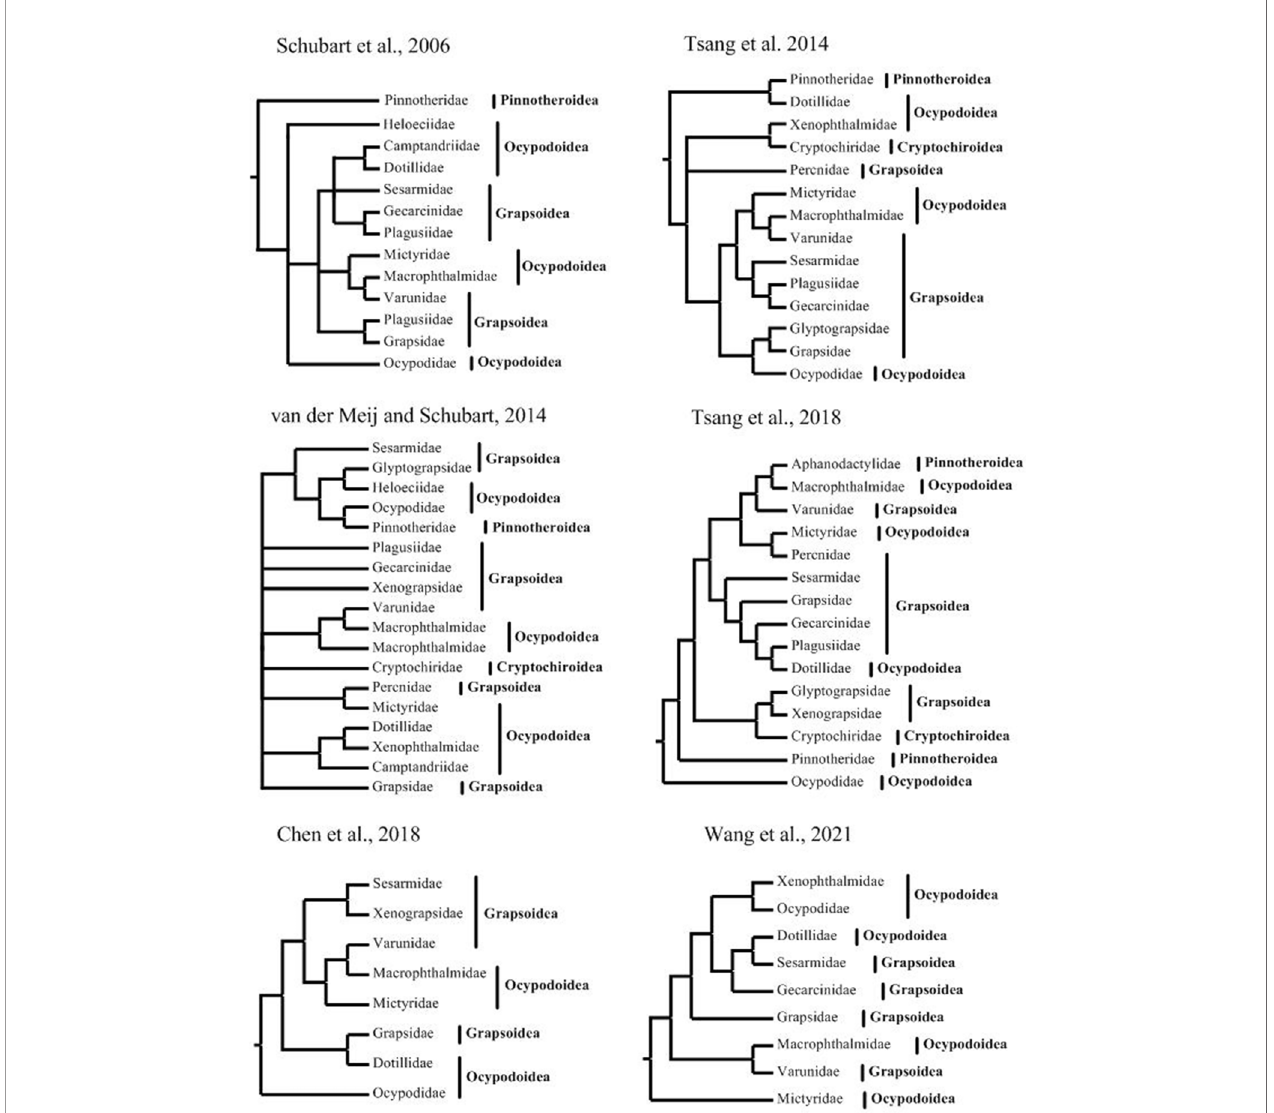
FIGURE 1 | Recent hypotheses of relationships at families and superfamilies of Thoracotremata based on molecular data. The studies summarized here reached different